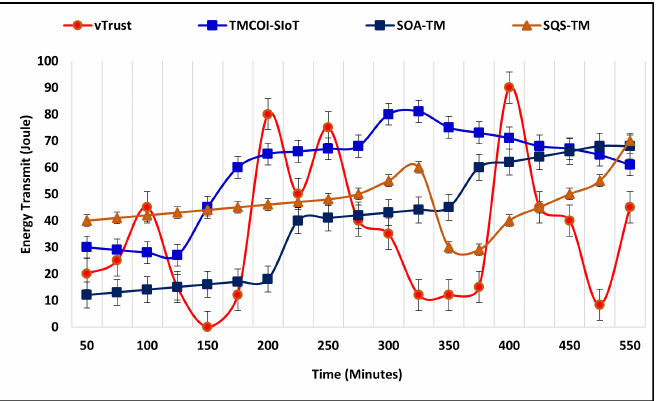
Figure 7. Average energy shared in rural environment.